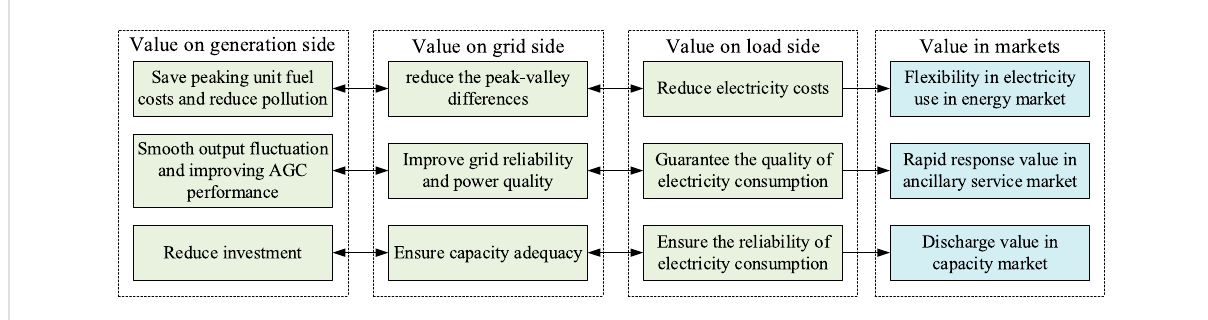
FIGURE 1 Value manifestation of energy storage for different market entities.